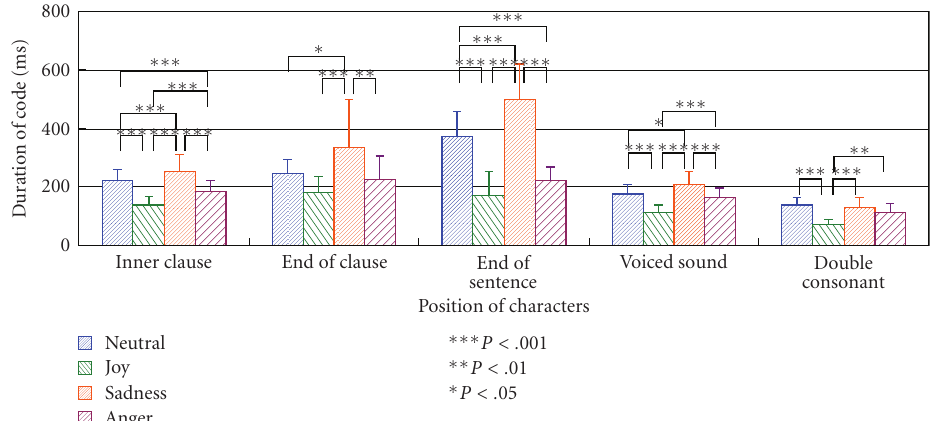
Figure 5: Mean of duration of code as a function of emotions and position of characters for two-handed Finger Braille (error bars represent standard